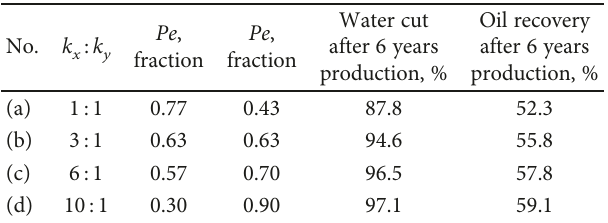
Figure 6: Three-dimensional color map surface of oil recovery percent of reserves when the water injection well has fracture. (a) Reservoir permeability k : k is 1:1; (b) reservoir permeability k x y k : k is 10:1. x y Table 4: Optimal penetration ratio of production well fracture when the injection well is